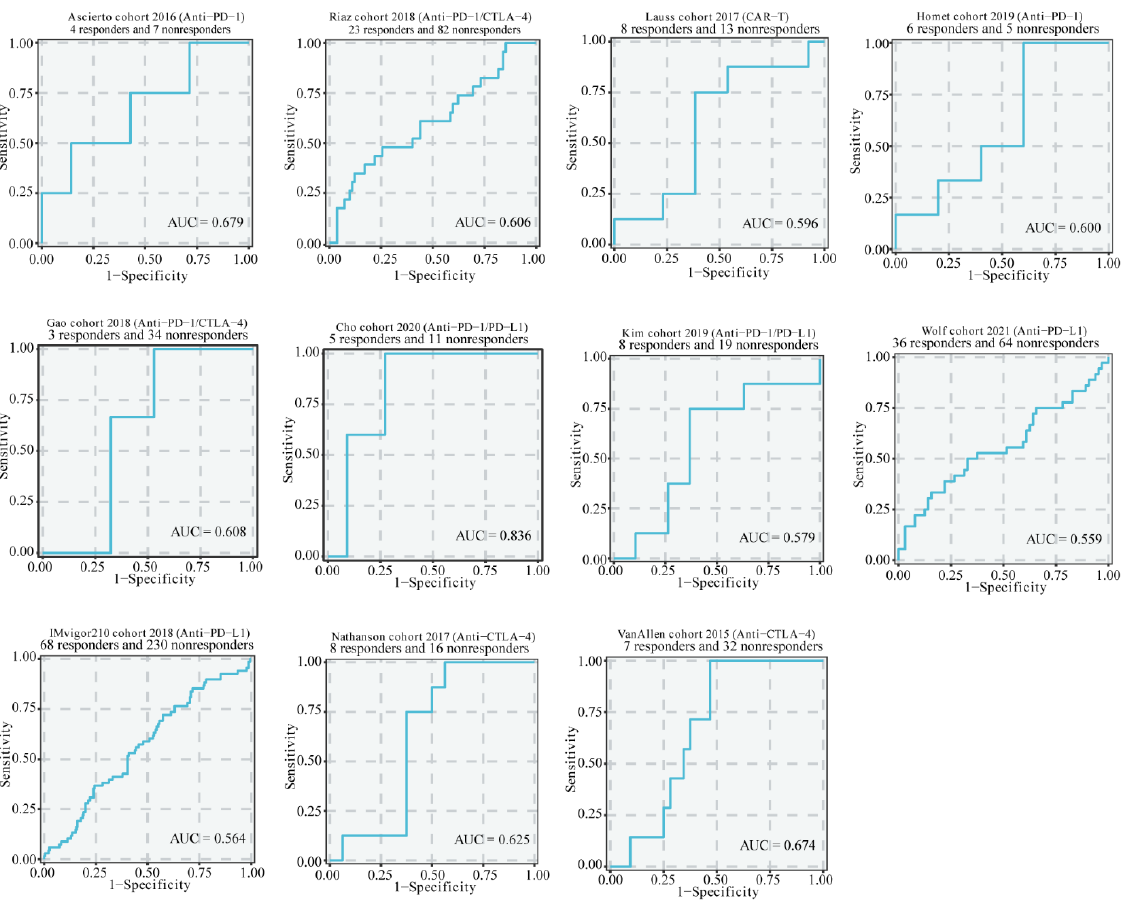
Figure 8. The predictive power of CYP1B1 in GSE67501, GSE91061, GSE100797, GSE111636, GSE115821, GSE126044, GSE135222, GSE173839, IMvigor210, Nathanson cohort 2017, VanAllen cohort 2015 immune